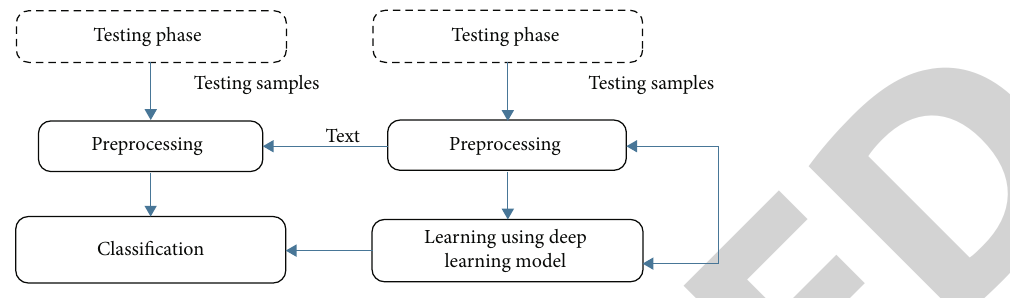
Figure 2: Computing-based classi fi cation process. Table 1: Parameter analysis table for the proposed federated computing